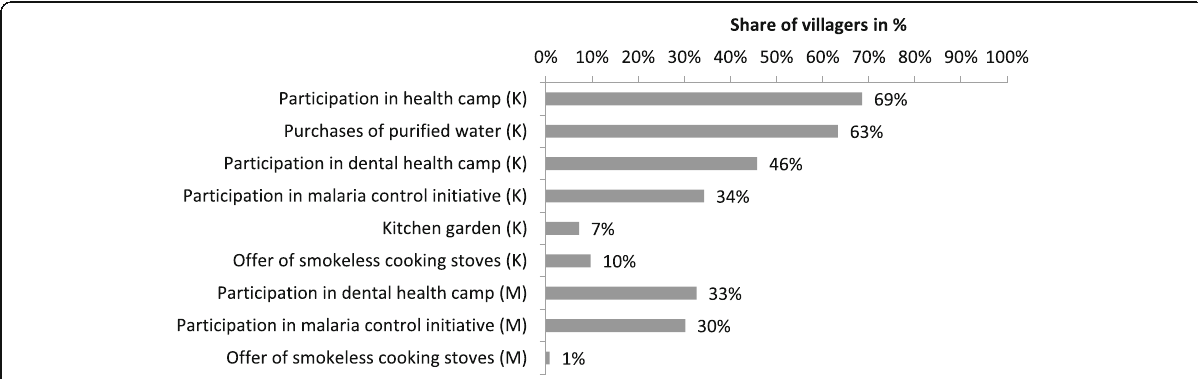
Fig. 2 MVP participants in Bayer Crop Science ’ s health activities. Source: MVP Panel Survey, 2nd wave 2014, own calculations. K = Kadivala, M =